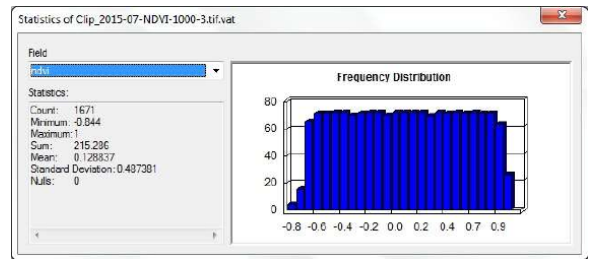
Figure 16. Sector 3 - Distribution frequency 10/07/2015